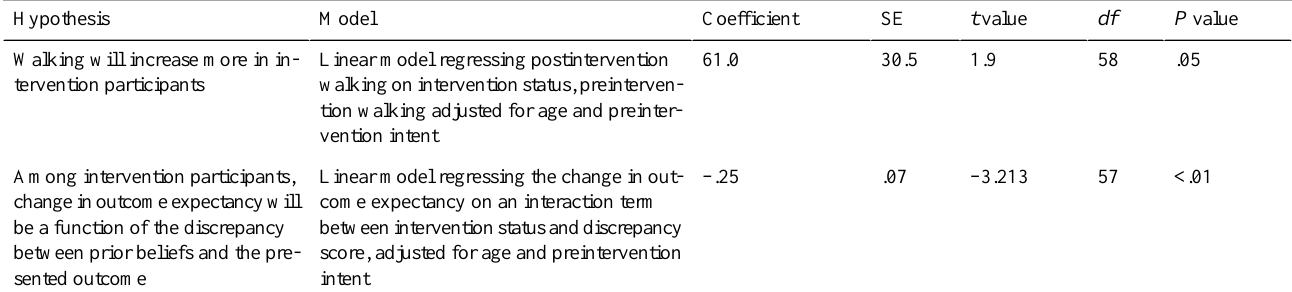
Table 3. Summary of hypotheses and results.